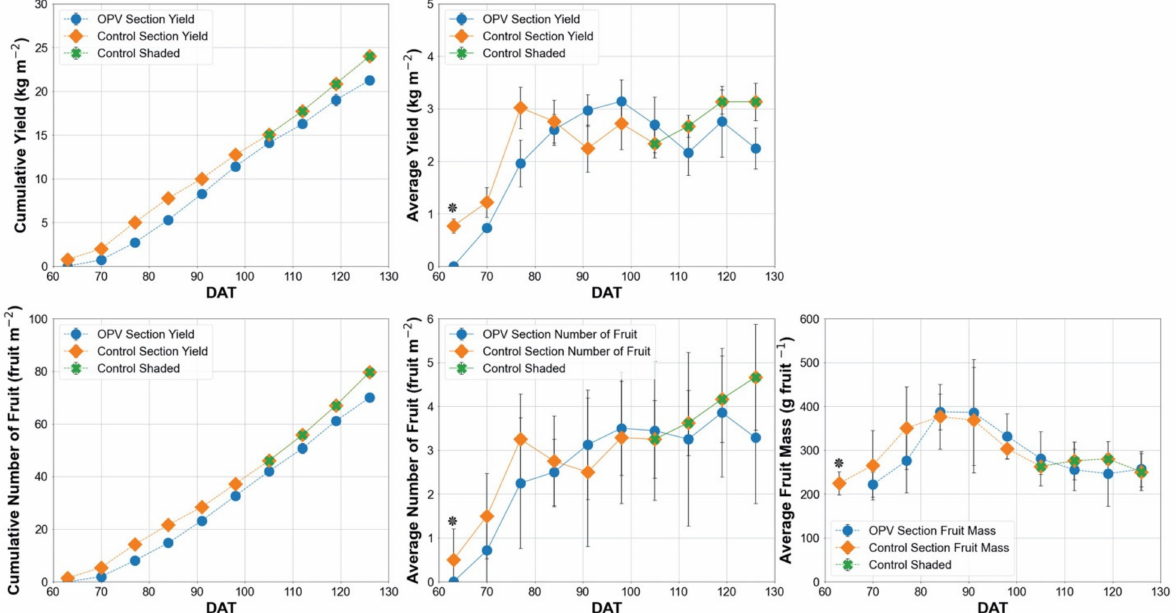
Figure 10. Weekly yield data in OPV and Control Sections for 10 harvests, with the first harvest 62 DAT (7 May 2020) and last harvest 125 DAT (7 July 2020). Each data point represents the averaged value of 6 sample plants located in the inner rows of each section, with bars representing the standard deviation. The indicates a significant difference between the samples for that week of